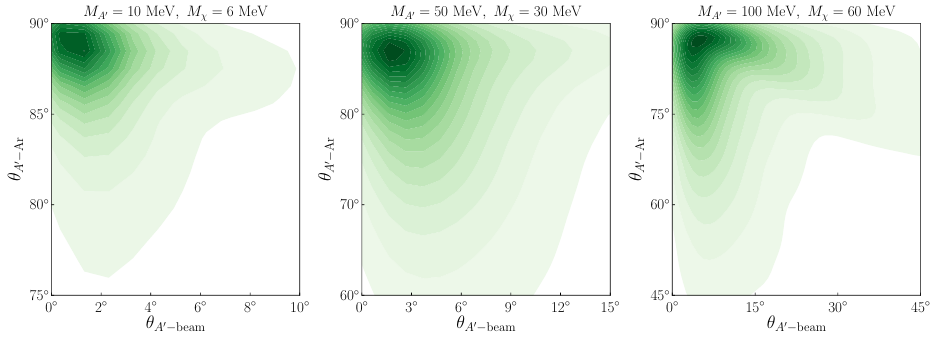
Figure 6 . The angular distributions of the (cid:12)nal state A 0 with respect to the incoming dark matter beam direction ( (cid:18) A 0 beam ) and with respect to the recoiling argon nucleus direction ( (cid:18) A 0 Ar ), for (cid:0) (cid:0) three dark matter and dark photon mass combinations. We (cid:12)x the dark matter to dark photon mass ratio to be M (cid:31) =M A 0 = 0 : 6. Note the di(cid:11)erent ranges in the axes of the di(cid:11)erent panels.